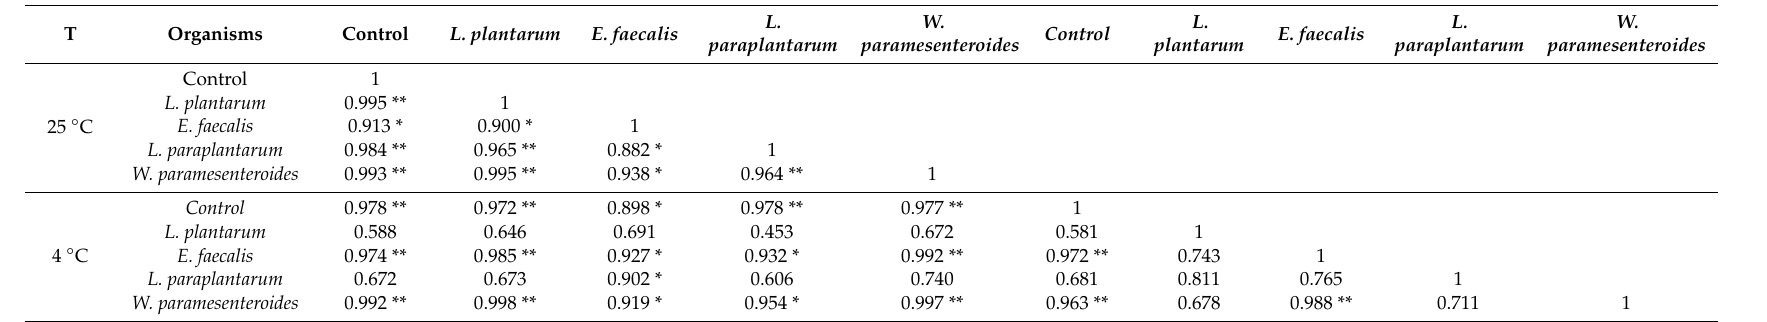
Table 4. Pearson’s correlation coe ffi cients of Lactobacillus counts in the grape marmalade at both 25 ◦ C and 4 ◦ C.